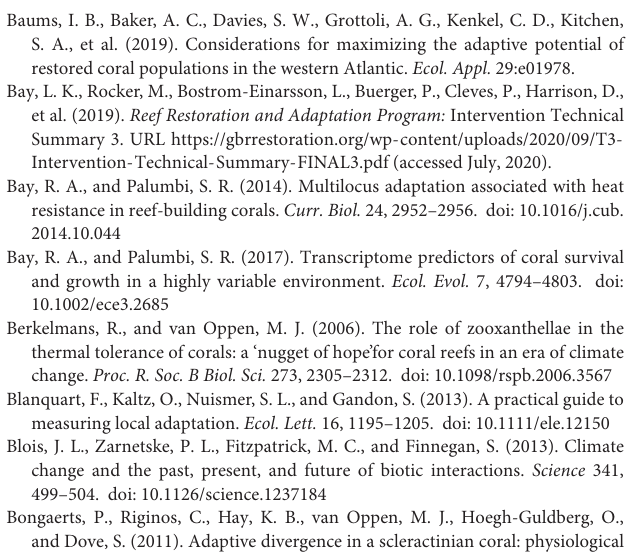
Supplementary Table 7 | Heat stress analysis of deviance table from Wald’s Chi-square type III test on the generalized linear mixed model of yield with data taken 18 months after reciprocal transplantation (August 2013). Bold values indicate statistical significance.